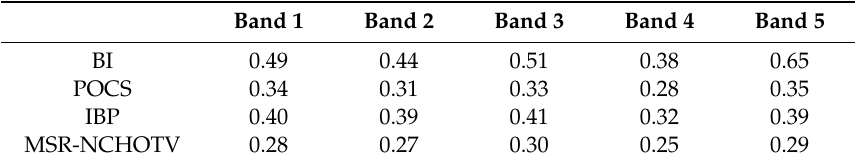
Figure 8. The SRR images for Experiment 2 obtained using (a) BI, (b) POCS, (c) IBP, (d) MSR-NCHOTV. Panels with the suffixes 1, 2, and 3 show local detail magnifications area of the corresponding panel in the left column. Table 5. Evaluation results for image sharpness for Experiment 2.